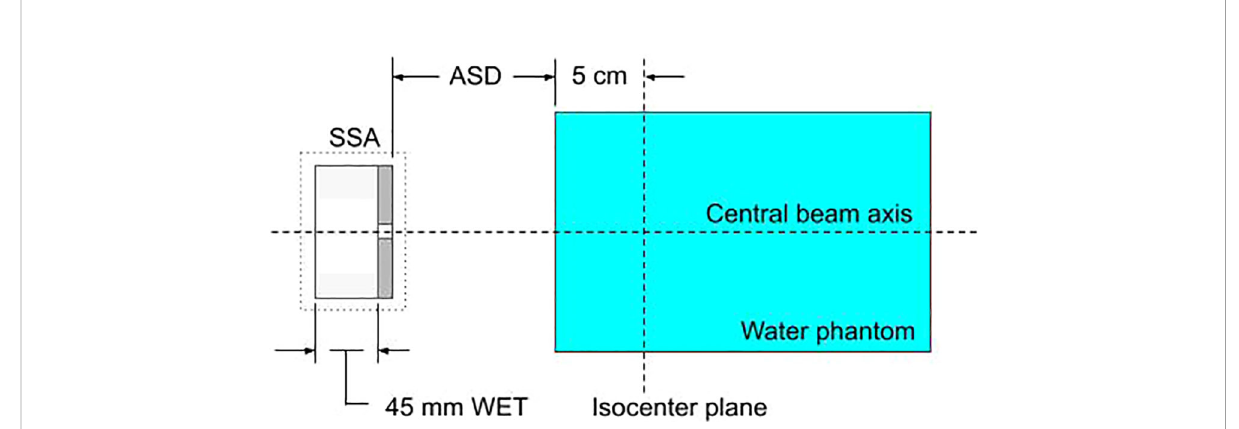
FIGURE 2 A diagram of the setup for characterizing the SSA within the Monte-Carlo simulation, MCsquare. Protons pass sequentially through the range shifter, the cylindrical opening of the SSA, and the water phantom. The fi gure shows a range shifter WET of 45 mm and zero gap between the range shifter and the